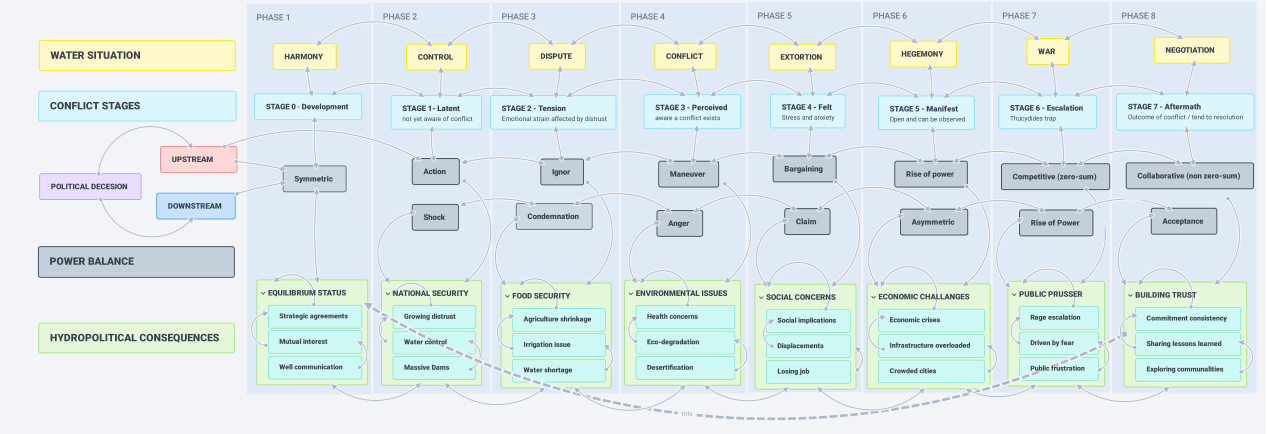
Figure 2. The theory of